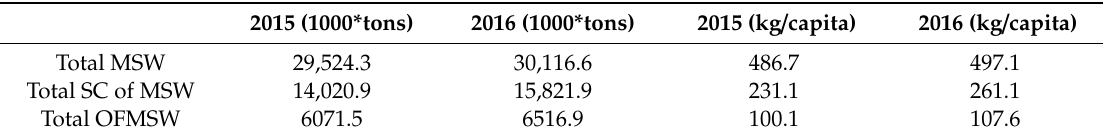
Table 2. Statistical data in Italy regarding municipal solid waste (MSW) [67]. OFMSW—organic fraction of municipal solid waste; SC—separated